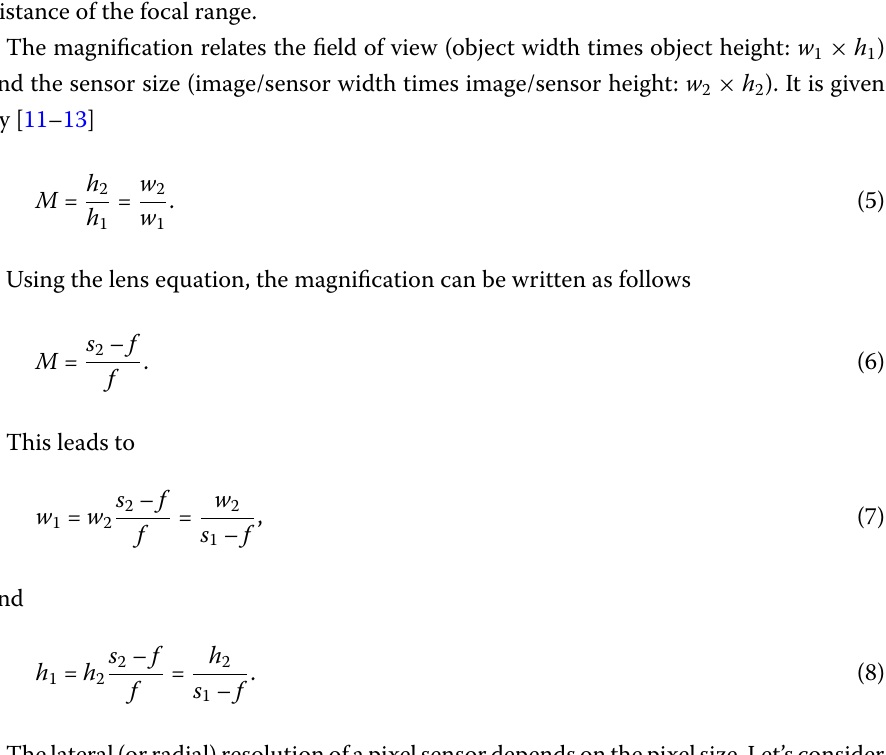
2 determines the minimum 2,max